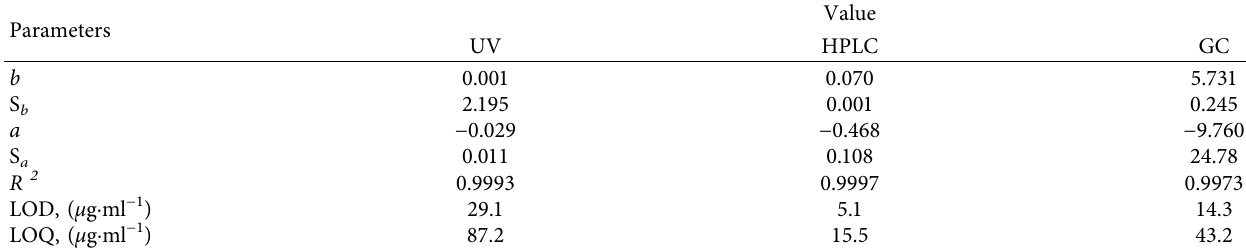
Table 3: Criteria of linearity and sensitivity of BAC determination in the “VIROSAN F”.